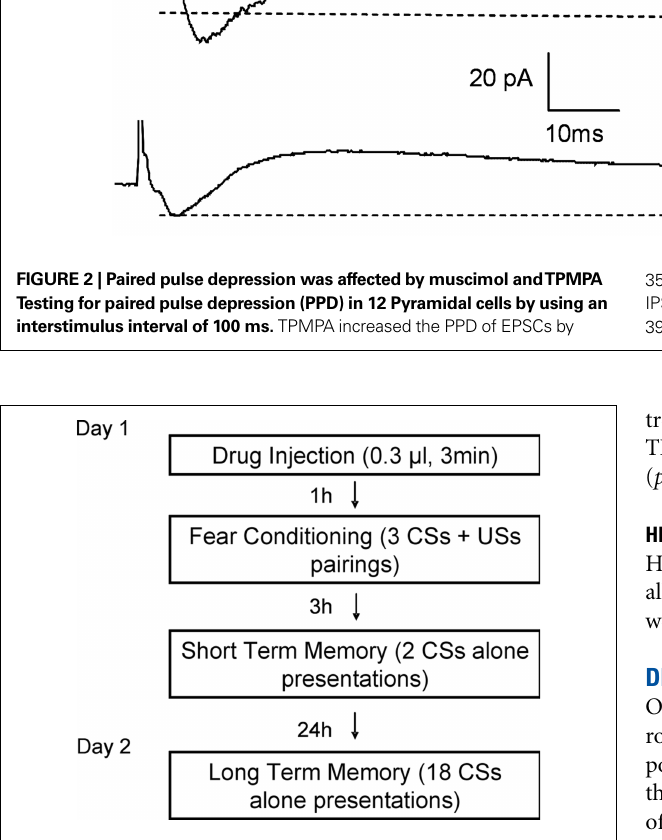
FIGURE 3 | Design of in vivo behavior experiments. Outline of general behavioral procedures and timing of pre-training injections relative to